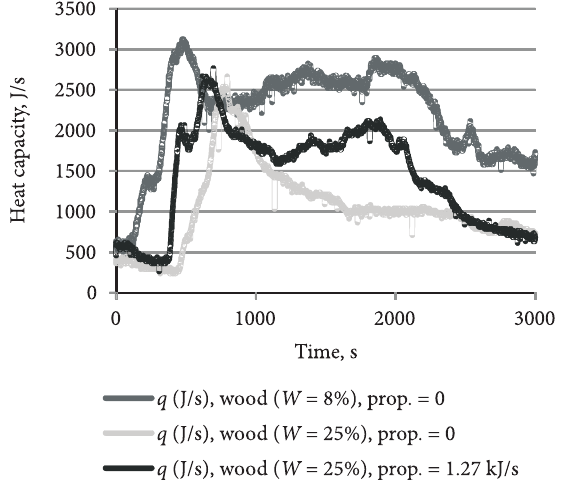
Fig. 3. The effect of wood pellets moisture content and propane-butane supply on heat production rate